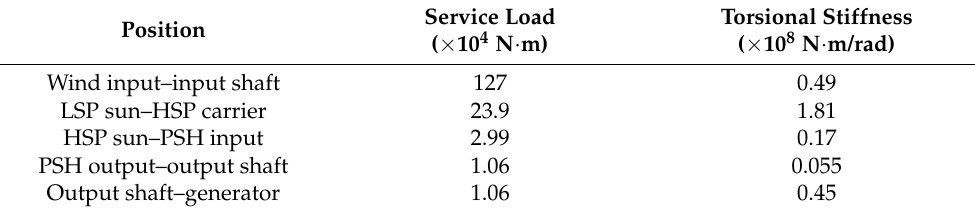
Table 5. Parameter identification results of the connections and shafts.